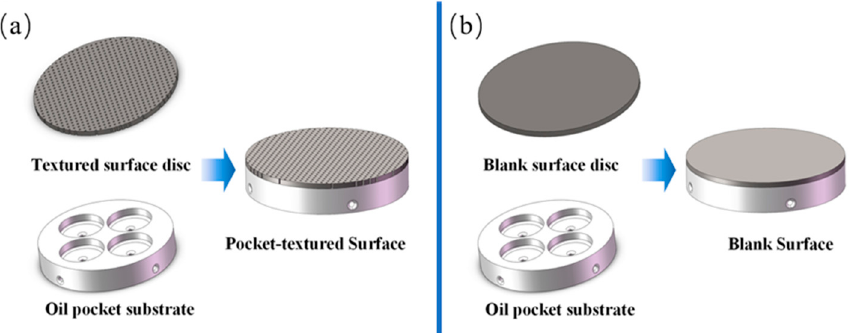
Figure 1. The configuration diagram of the ( a ) pocket-textured surface and ( b ) blank